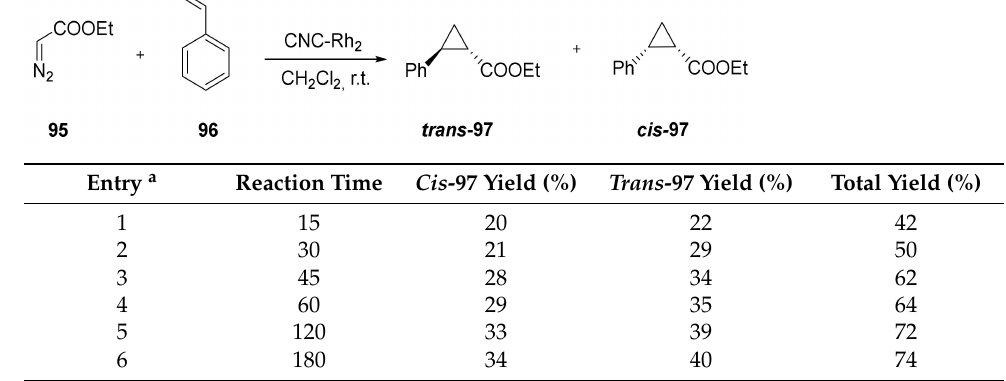
Figure 4. Proposed Mechanism for the synthesis of aryl-2,3-dihydro-1H-perimidines 87a–87l catalyzed by Fe 3 O 4 @CNCs/BF 0.2 . Table 10. Reaction of styrene with EDA catalyzed by CNC-supported rhodium catalyst.